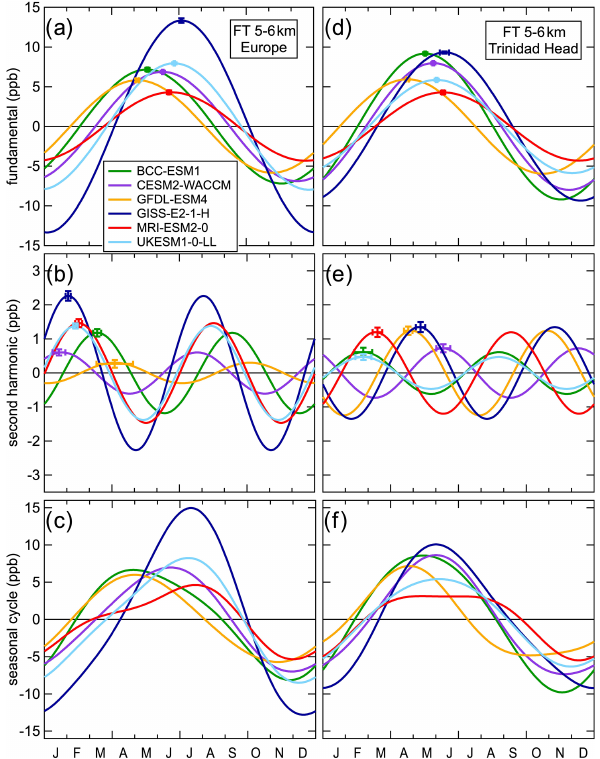
Figure 3. Harmonic analysis of the simulated ozone preindustrial seasonal cycle at two remote FT sites. Curves, color-coded accord- ing to model, give the fundamental (a, d) , second harmonic (b, e) and total seasonal cycle (c, f) , which is calculated from the sum of the two harmonics. Error bars at the maxima of the harmonic curves indicate the confidence limits of the amplitudes and phases (some are too small to clearly